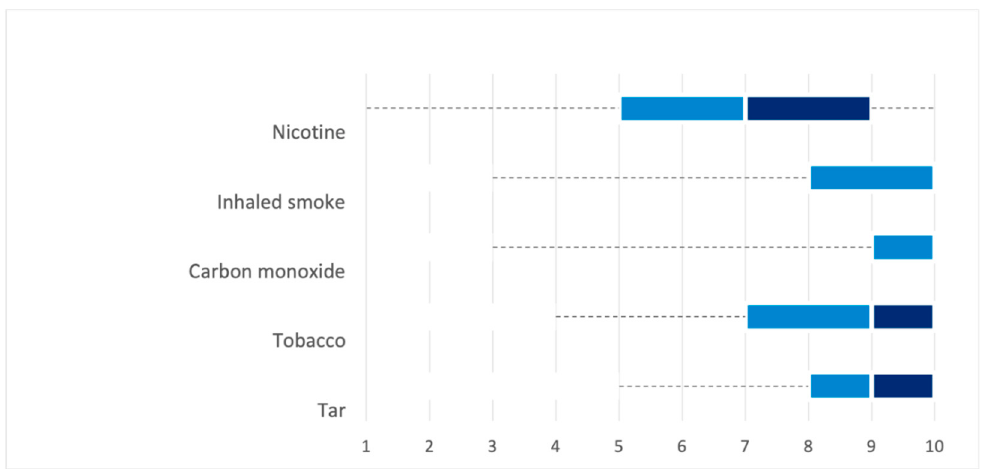
Figure 2. Health risk scores for smoking components. Tar, tobacco residue.